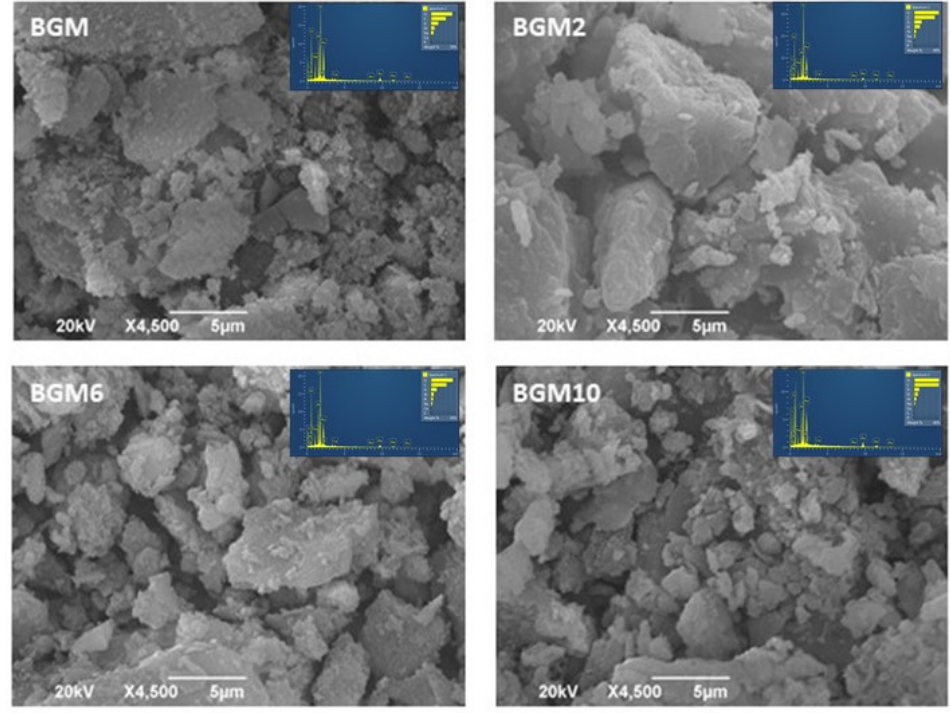
Figure 8. SEM microphotographs of BGM, BGM2, BGM6, and